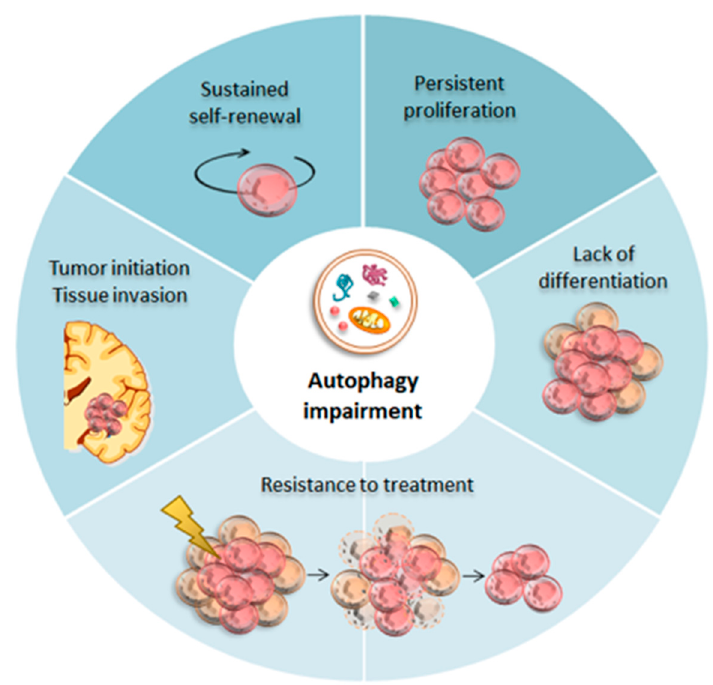
Figure2. AutophagyinGliomaStemCells(GSCs). Duringdevelopment, baselineautophagyguarantees Figure 2. Autophagy in Glioma Stem Cells (GSCs). During development, baseline autophagy neuronal di ff erentiation and homeostasis within the neural stem cells (NSCs) niche. Impaired autophagy guarantees neuronal differentiation and homeostasis within the neural stem cells (NSCs) niche. seems to be crucial for GSCs tumor initiation. In fact, when autophagy is impaired (central while circle), Impaired autophagy seems to be crucial for GSCs tumor initiation. In fact, when autophagy is GSCs undergo uncontrolled self-renewal and rapid proliferation in the absence of di ff erentiation. GSCs impaired (central while circle), GSCs undergo uncontrolled self-renewal and rapid proliferation in also infiltrate within the healthy brain parenchyma, thus displaying enhanced invasion and resistance the absence of differentiation. GSCs also infiltrate within the healthy brain parenchyma, thus to therapy, the two hallmarks of GBM displaying enhanced invasion and resistance to therapy, the two hallmarks of GBM aggressiveness.